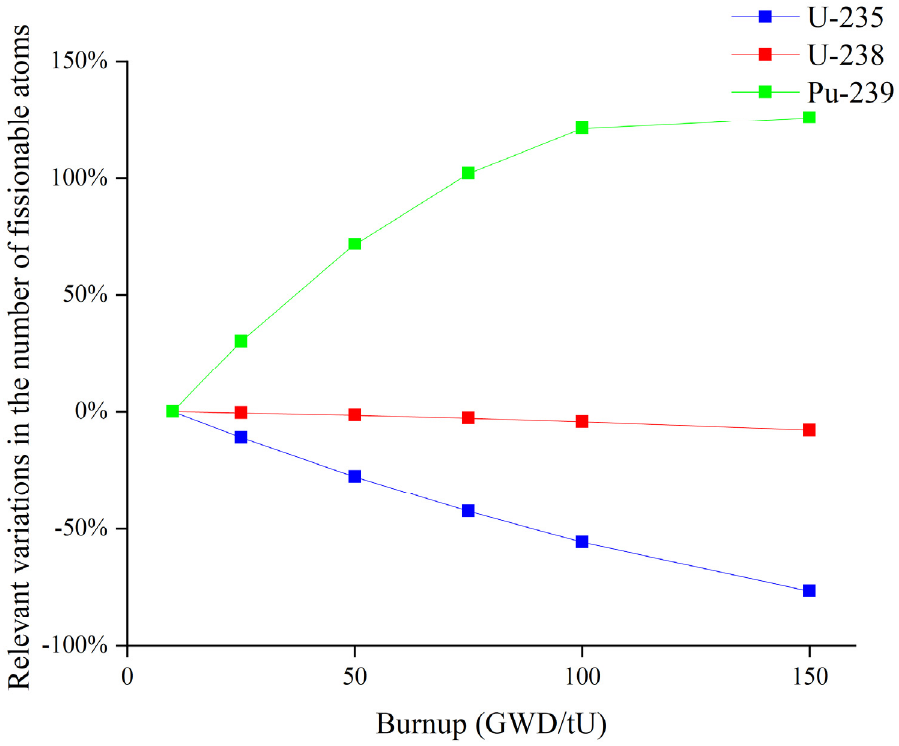
Figure 8. Relevant variations in the number of fissionable atoms ( 235 U, 238 U, and 239 Pu).